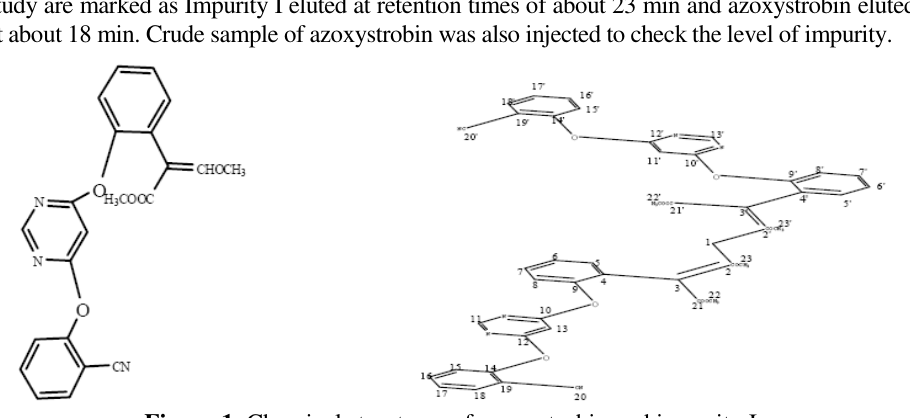
Figure 1 . Chemical structures of azoxystrobin and impurity